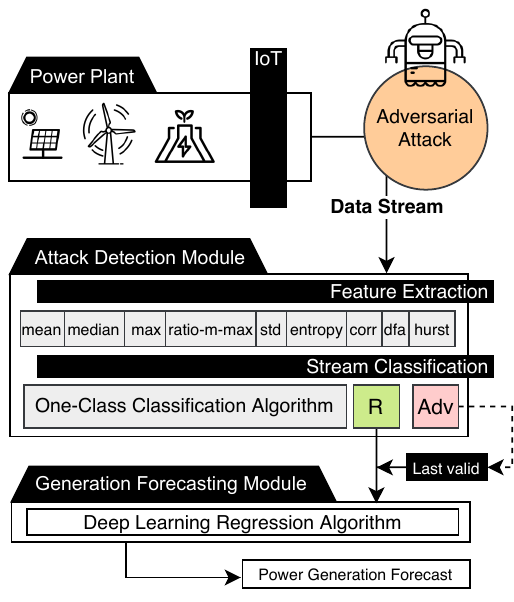
Figure 1. Proposed approach